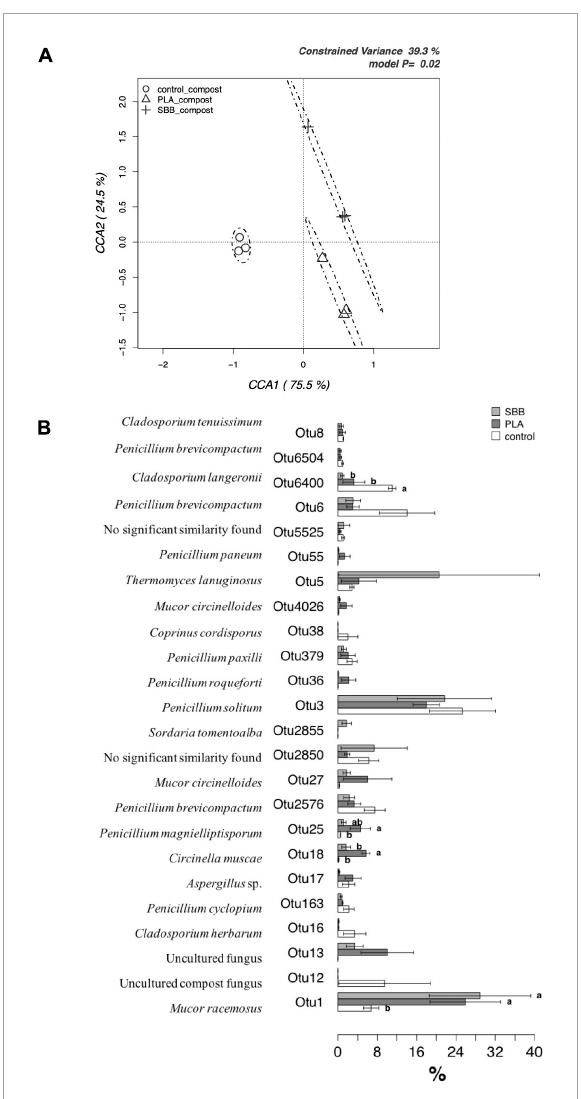
FIGURE8 Fungal community in compost. (A) Hypothesis-driven canonical correspondence analysis (CCA) model performed on the total fungal OTUs relative abundance data from composts of each treatment (OFMSW, control; PLA; SBB). (B) Metastats model on the relative abundances of genera comprising 99.9% of each treatment’s fungal diversity in composts (OFMSW, control; PLA; SBB). OTUs showing significant differences according to the false discovery rate correction are highlighted with letters. PLA, polylactic acid; SBB, starch-based bioplastic; OFMSW, organic fraction of municipal solid